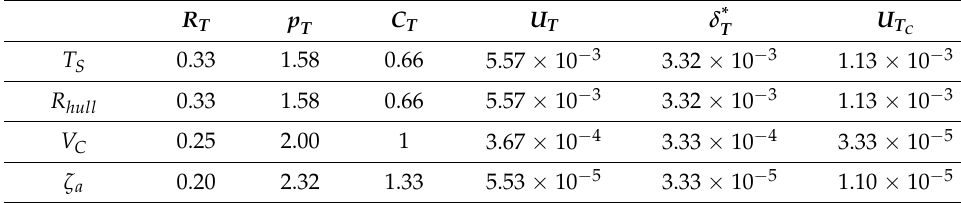
Table 5. Time step convergence verification.